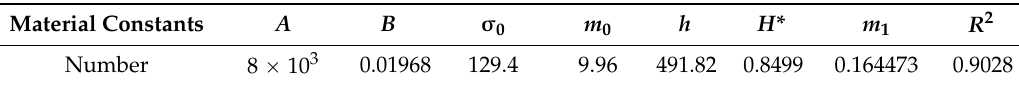
Table 5. Creep model parameters of 2219 aluminum alloy ( Q 2 = 36.2 kJ/mol). Material